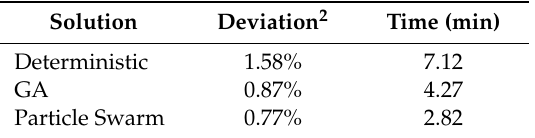
Table 8. Quadratic deviations and the execution time of each algorithm.